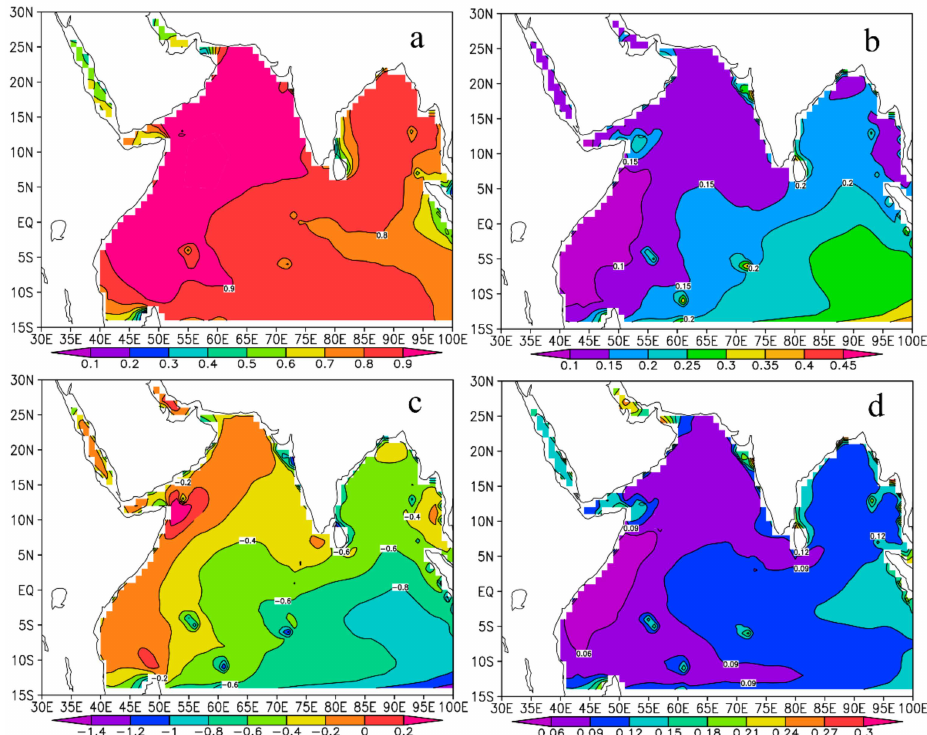
Figure 2. Comparison coe ffi cients for the significant wave heights (SWH) from the WAVEWATCH-III (WW3) wave model in 2017 and the SWH from the altimeter: ( a ) CC, ( b ) RMSE, ( c ) bias, and ( d )